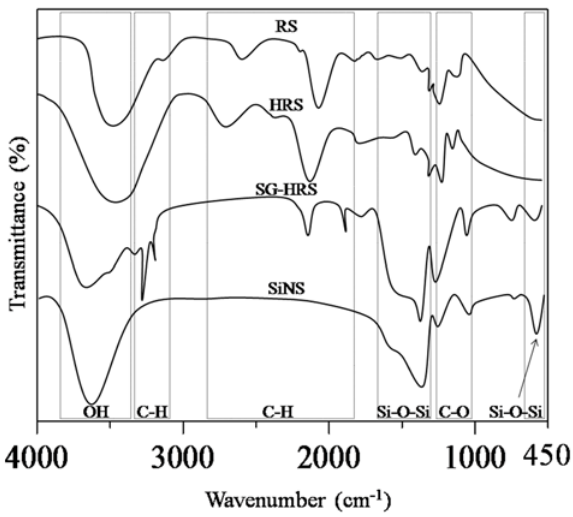
Figure 4. Fourier transform infrared (FTIR) spectra of rice starch (RS), hydrolysis of rice starch (HRS), SG ‐ HRS, and nanostructured silica (SiNS).